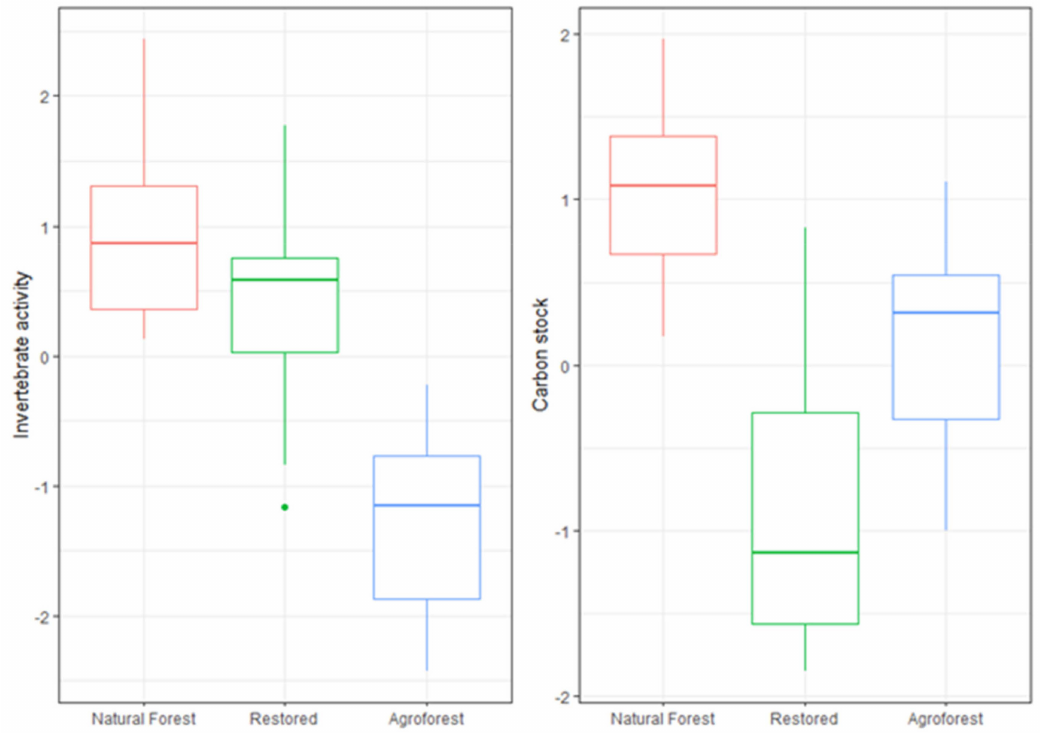
Figure A2. Boxplot between ecosystem types and ecosystem services dimensions (PC1—invertebrate activity; PC2—carbon stock dimensions) (see Table 2). The line inside the box represents the median value, the box limits are the 25th and 75th percentiles, error bars show 10th and 90th